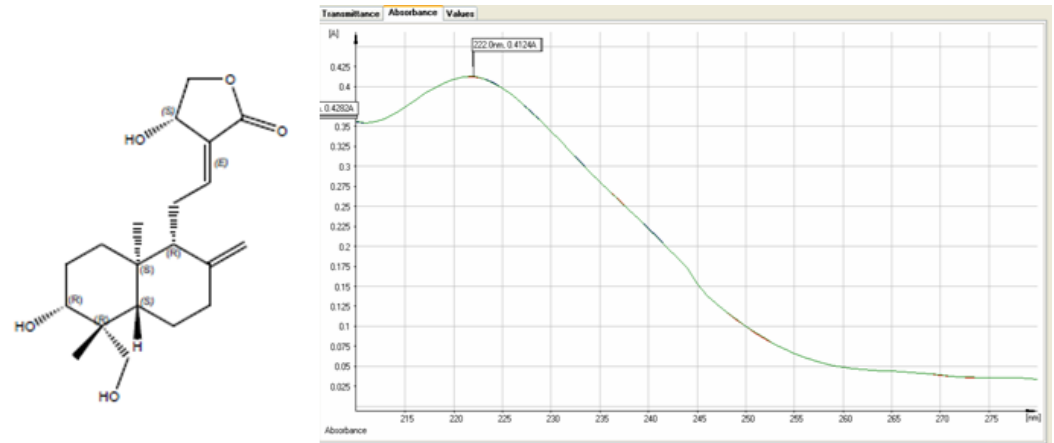
Figure 2. Andrographolide chemical structure (left) and UV spectrum in methanol